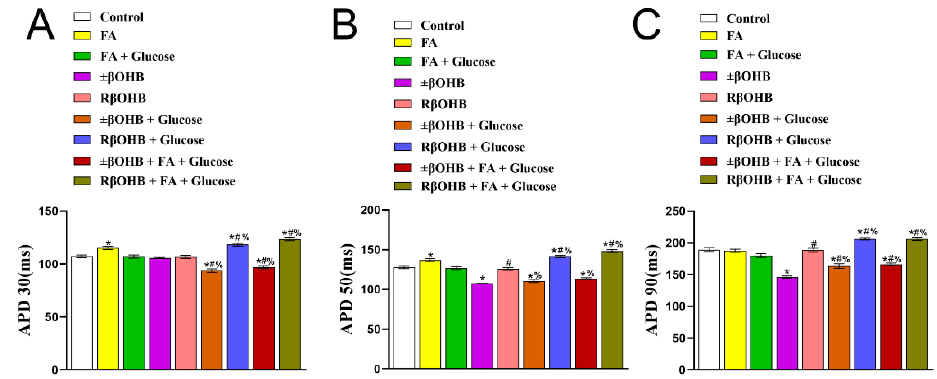
Figure 4. Quantification of FluoVolt optical AP durations (APD) recorded from iPS-CMs cultured in various media. The time it takes for an action potential to complete 30% repolarization (APD30) ( A ), the time it takes for an AP to complete 50% repolarization (APD50) ( B ), the time it takes for an AP to complete 90% repolarization (APD90) ( C ). * p < 0.008 vs. control. # p < 0.008 vs. ± β OHB. % p < 0.008 vs. R β OHB.